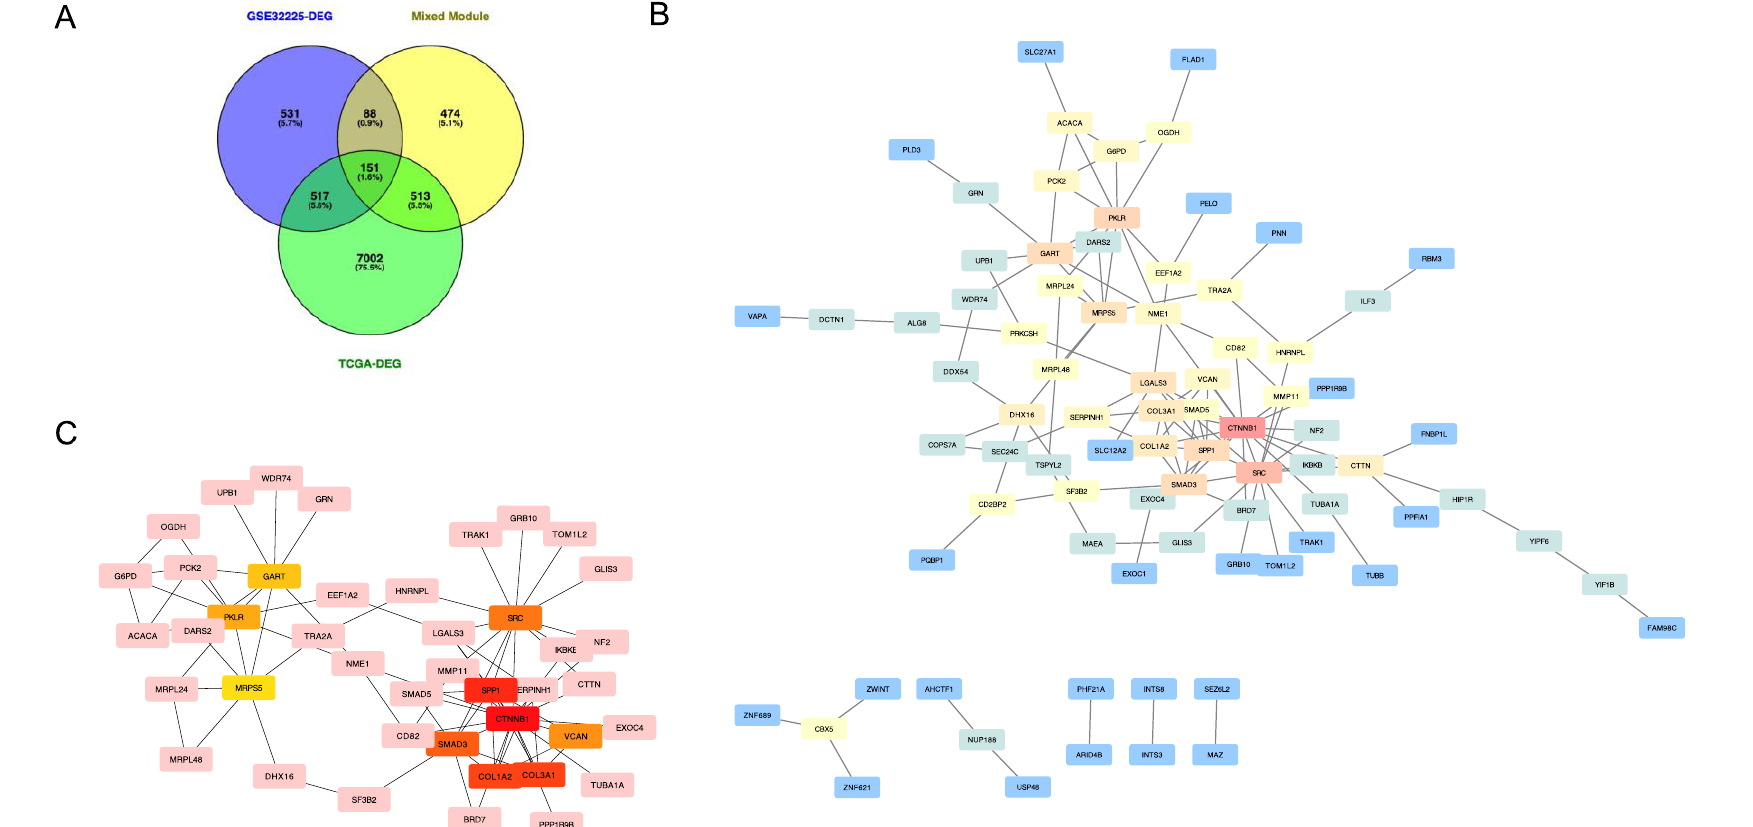
Figure 5. Identification of top 20 hub genes. ( A ) Venn diagram of GSE-DEGs, TCGA-DEGs and mixed module. ( B ) Protein–protein interaction network generated by the overlapped genes in three datasets. Red: high score; orange-yellow: intermediate score; blue: low score. ( C ) Protein–protein interaction network among 10 hub genes generated by Cytohubba . Greater scores in degree algorithm and relevant location in the network are represented by darker colors.